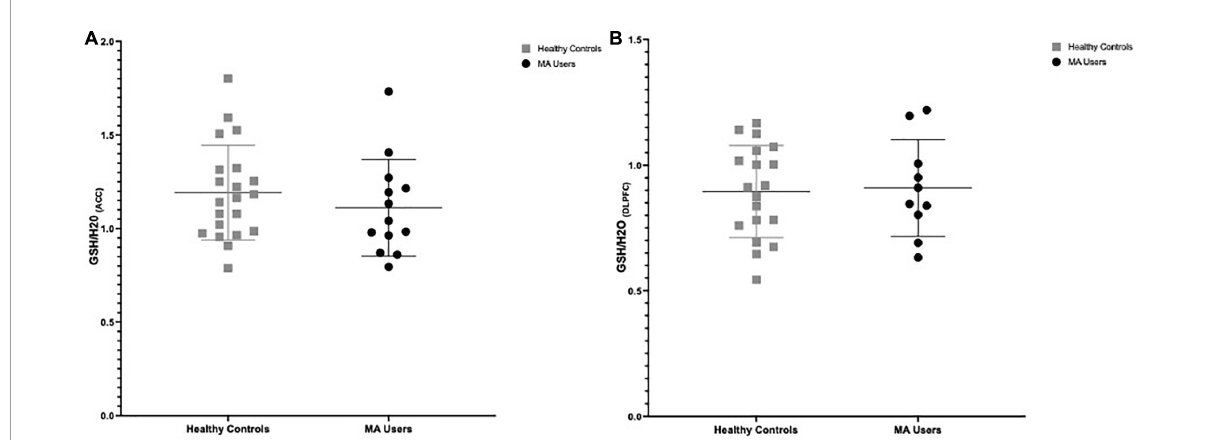
FIGURE2 Group differences in glutathione (GSH) between methamphetamine (MA) users (black circles) and HA (gray squares). (A) GSH/H20 in the anterior cingulate cortex (ACC): No group differences in GSH between MA users ( n = 13, mean: 1.111) and HC ( n = 21, mean:1.192) participants (–7.3% difference, p = 0.375). (B) GSH/H20 in the dorsolateral prefrontal cortex (DLPFC): No group differences in GSH between MA users ( n = 10, mean: 0.917) and HC ( n = 19, mean: 0.895) participants (% difference 1.6%, p = 0.847).